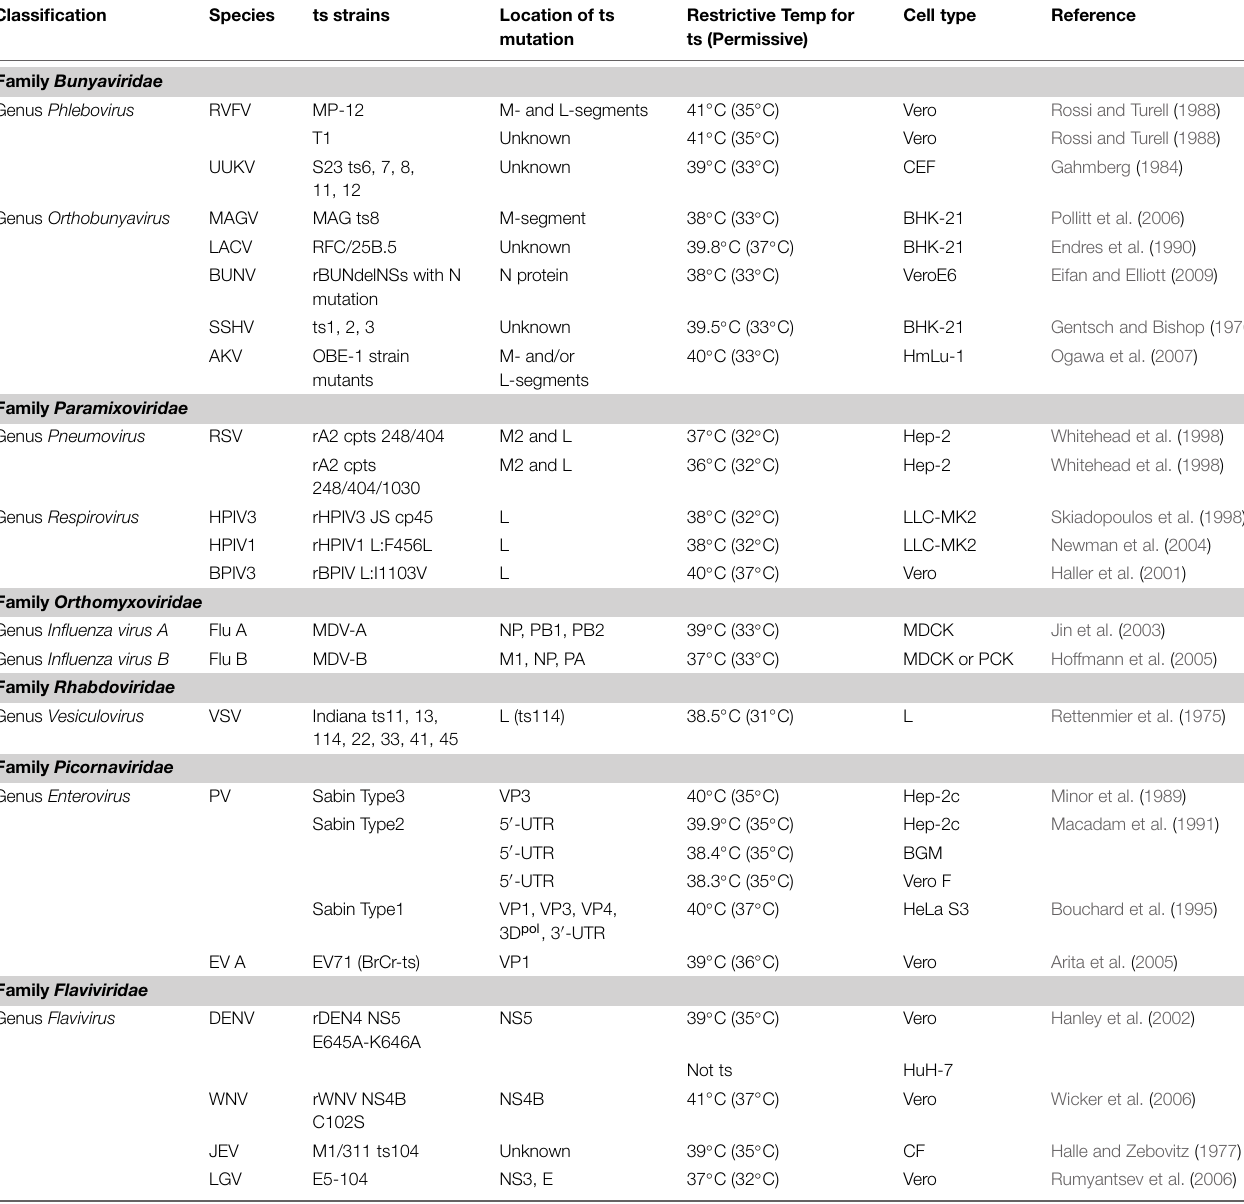
TABLE 1 | Determination of temperature-sensitive (ts) phenotypes for RNA viruses.